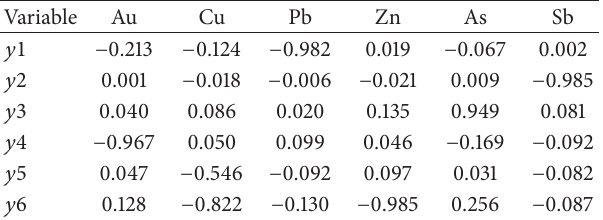
Table 3: Correlation coefficient